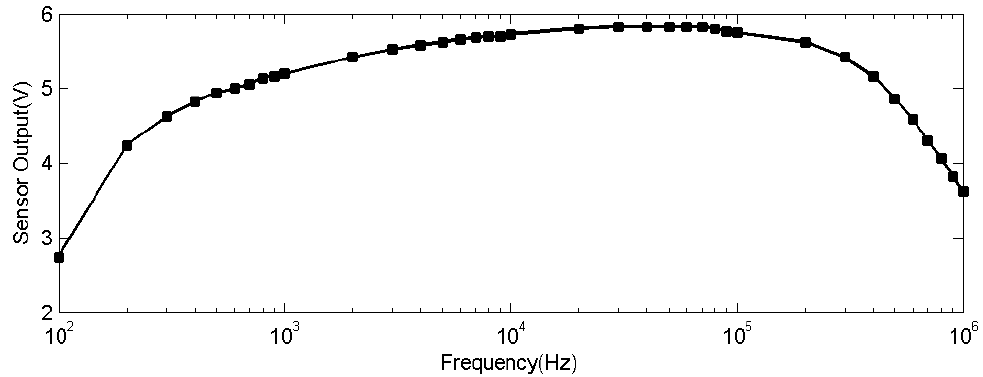
Figure 4. The sensor frequency response curve, the test frequency ranges from 100 Hz to 1 MHz.